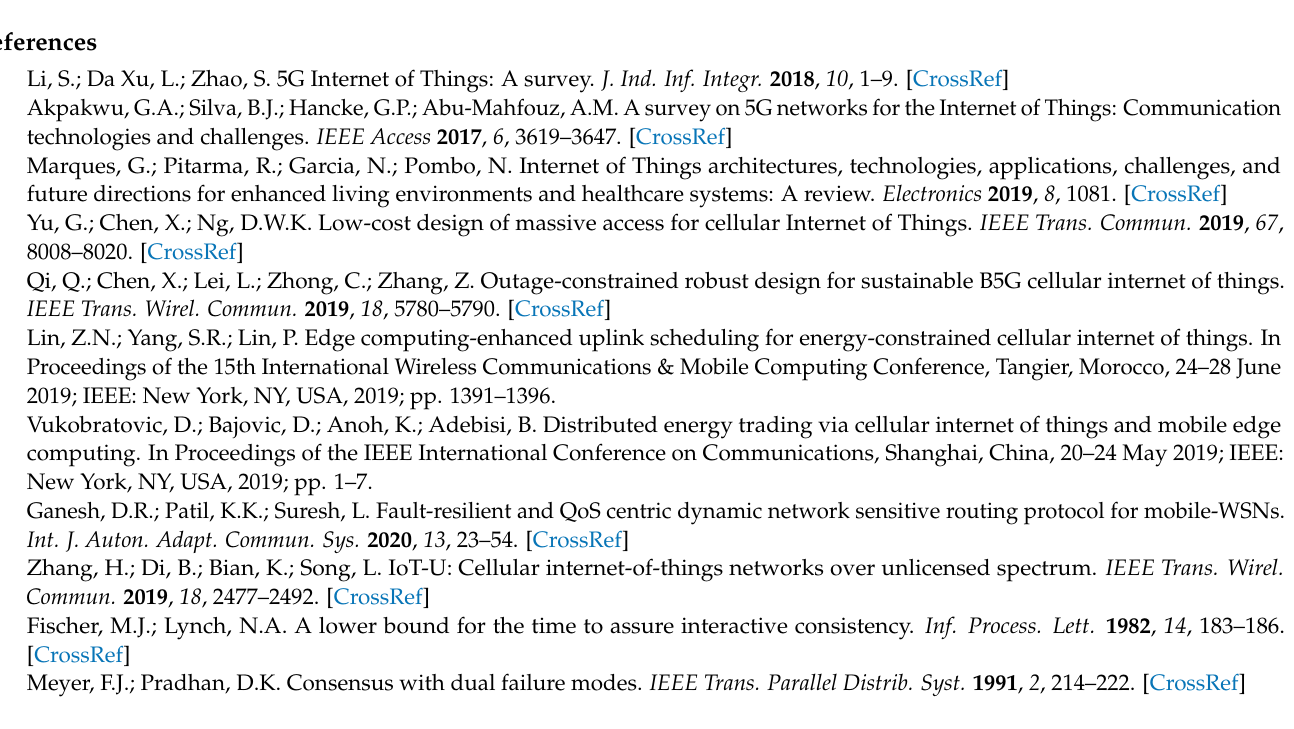
Figure A2. The pseudo code of